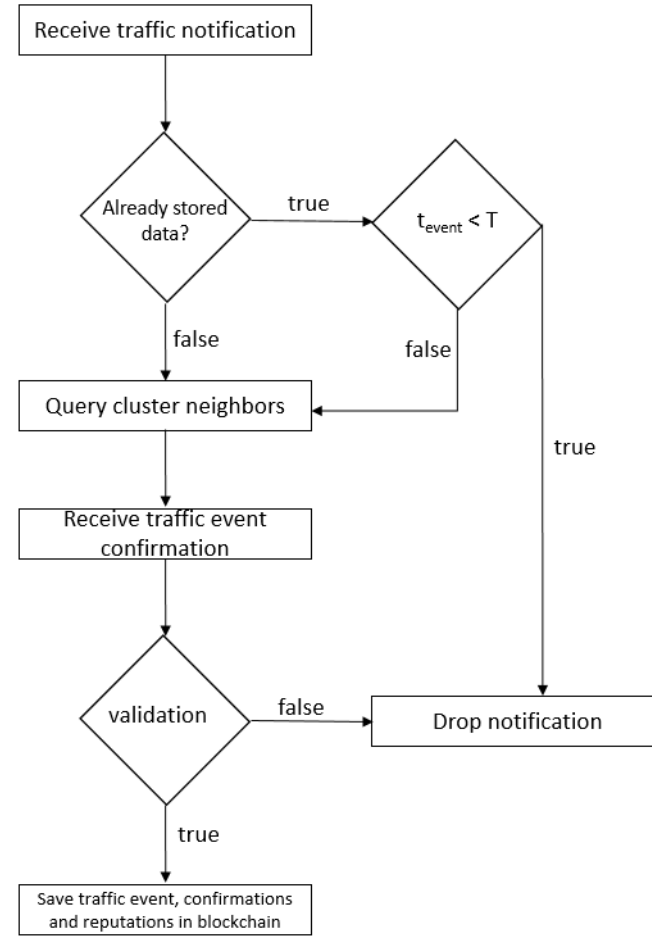
Figure 10. The process of updating ageing